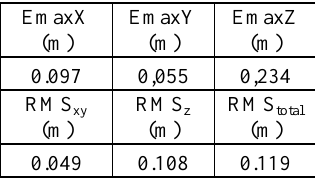
Table 3. Accuracy test estimating the errors committed in